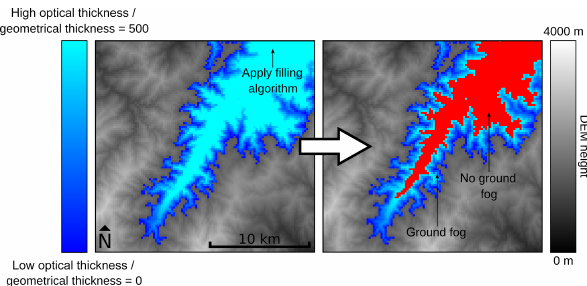
Figure 3. Theoretical geometrical thickness/optical thickness under the assumption of a perfectly plane-parallel cloud restricted by the terrain in its extent. The assumed cloud reaches from a base height of 900ma . s . l . up to a top height of 1400ma . s . l .